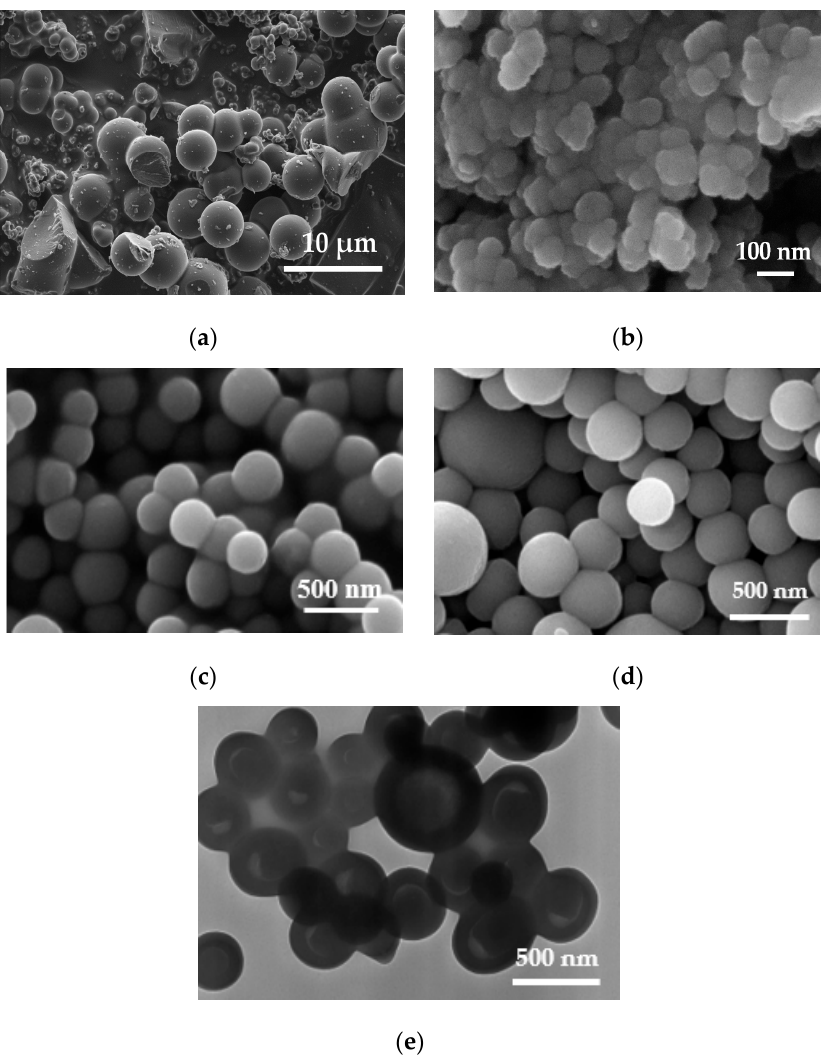
Figure 1. SEM images at 5 kV of carbon spheres synthesized from cane molasses (CM) at different water:CM ratios of ( a ) 1800:1 (CNRON1) and ( b ) 3600:1 (CNRON2). SEM image of latex spheres (template) ( c ). SEM ( d ) and TEM ( e ) images of carbon hollow nanospheres-CN.POL (water/resorcinol ratio of 5556:1; synthesized with a latex template).